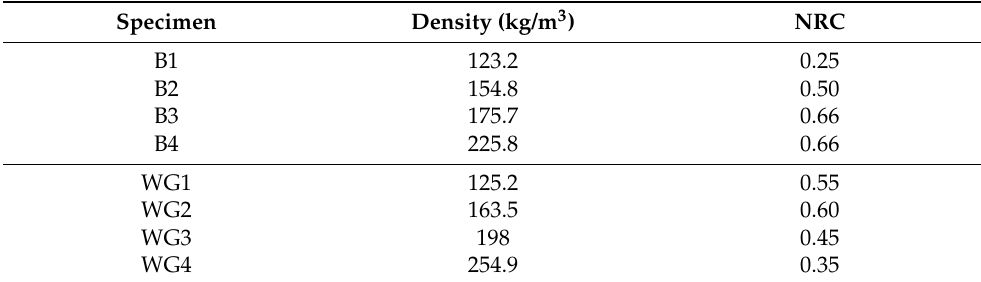
Table 4. Noise reduction coefficient NRC for the insulation boards with and without water glass application with a thickness of 30 mm.